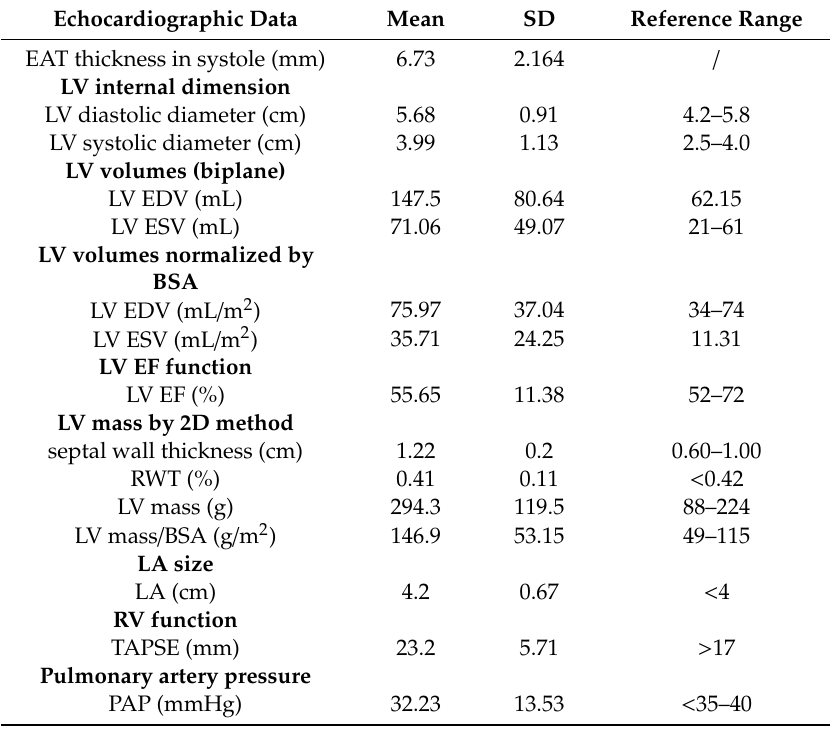
Table 2. Echocardiographic assessment of the overweight CVD subjects. Echocardiographic